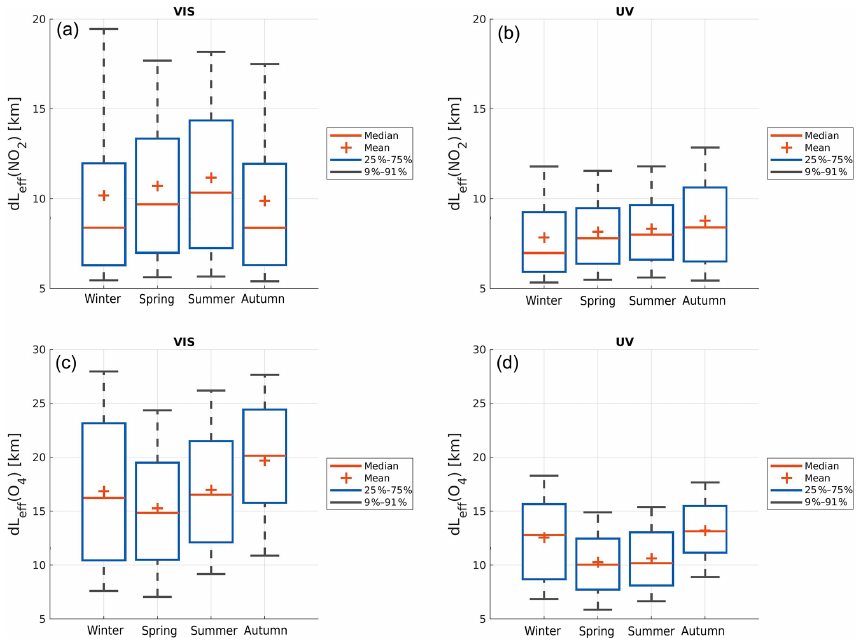
Figure 8. Panels (a) and (b) show the box-and-whisker plots representing the seasonal horizontal sensitivity as derived from all the azimuthal viewing directions by applying the parameterization method for the visible ( a and c ) and UV ( b and d ) spectral ranges. Every seasonal box contains the estimated dLeff (NO 2 ) of all the azimuthal viewing directions. Panels (c) and (d) show the corresponding estimates of dLeff (O 4